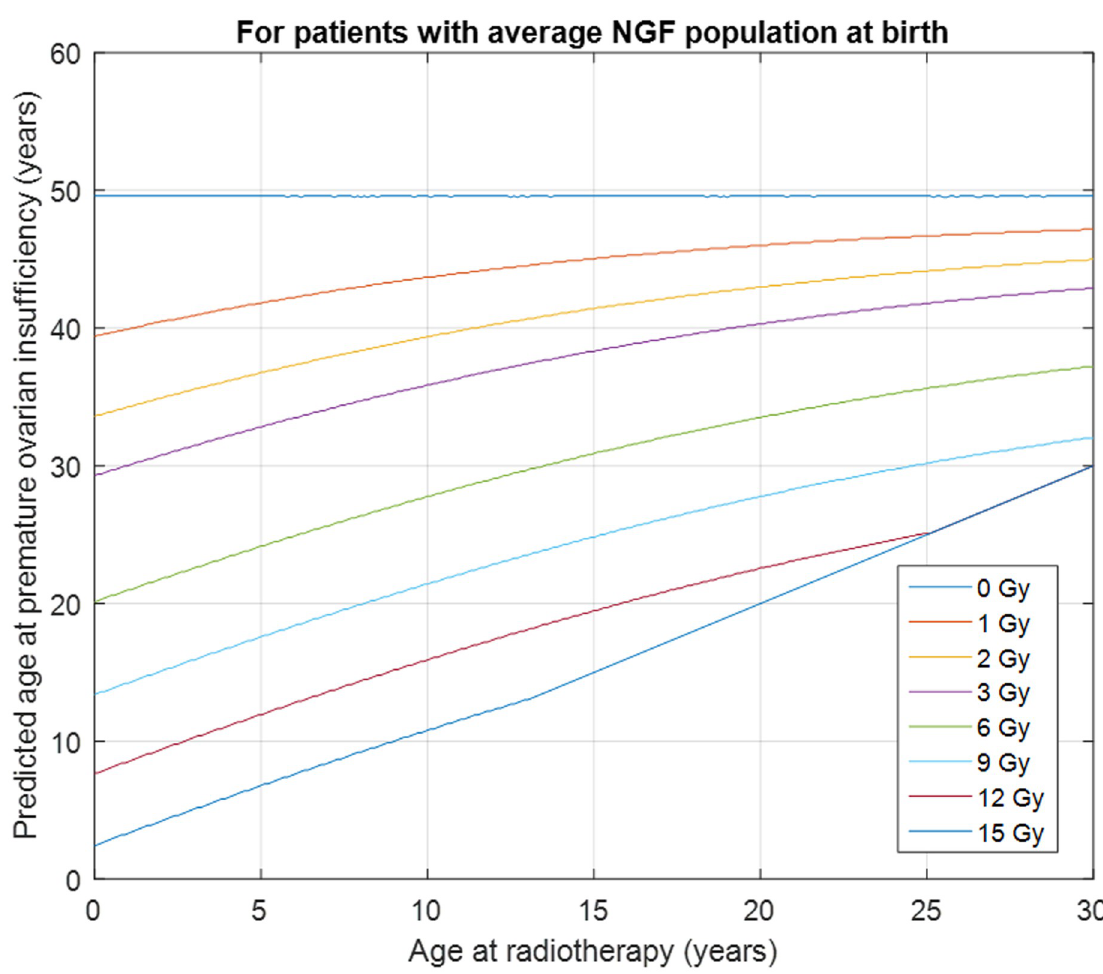
Fig 2. Predicted age at POI for known age and known dose to the ovary. A 5-year-old with average NGF population receiving 1 Gy to the ovary has predicted POI at age 42, losing about 8 years of reproductive lifespan; the same child treated with 12 Gy has predicted POI at age 12, indicating consideration of the use of fertility preservation techniques. The predictions are modifications of existing predictions [16] adapted to use the Wallace-Kelsey model of NGF population in healthy females